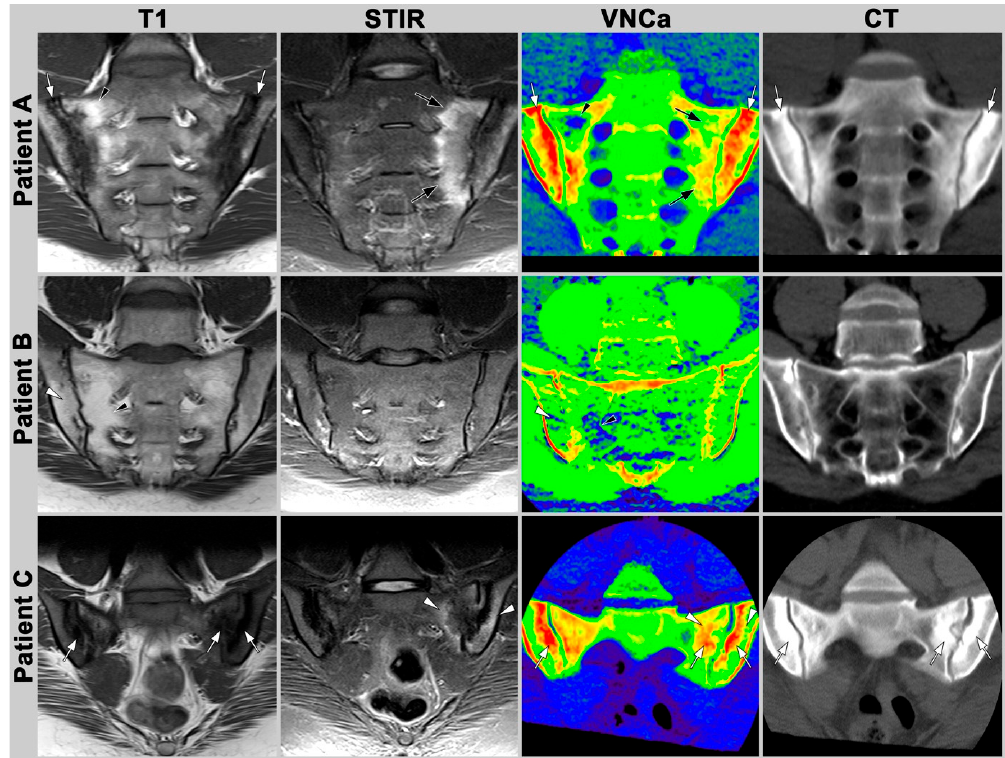
Figure 2. Examples illustrating appearance of osteitis and fatty bone marrow lesions in T1-weighted MR images, short tau inversion recovery (STIR) images, color-coded virtual non-calcium images (VNCa), and standard CT images of the sacroiliac